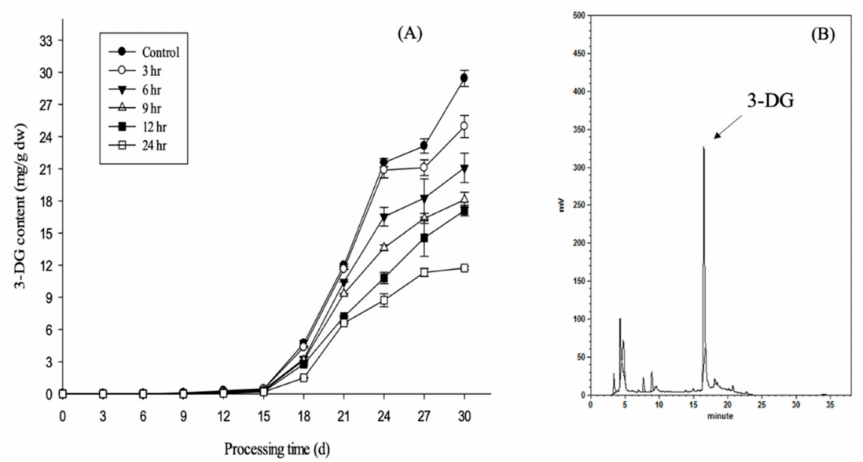
Figure 2. ( A ) 3-DG content (mg/g dry weight) in garlic with different impregnation times (0, 3, 6, 9, 12 and 24 h) during aging for 30 days. All values are means ± standard deviation ( n = 3). ( B ) HPLC chromatogram of black garlic at 312 nm.